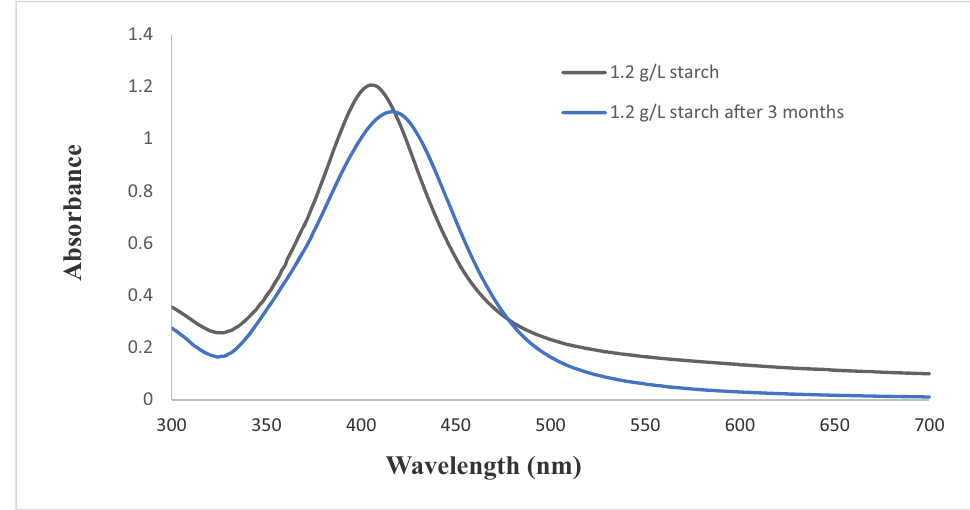
Figure 9: UV – Vis spectra of synthesized AgNPs with 5 g · L − 1 of AgNO 3 and 1.2 g · L − 1 of starch at 40 s of microwave exposure before and after 3 months of synthesis.